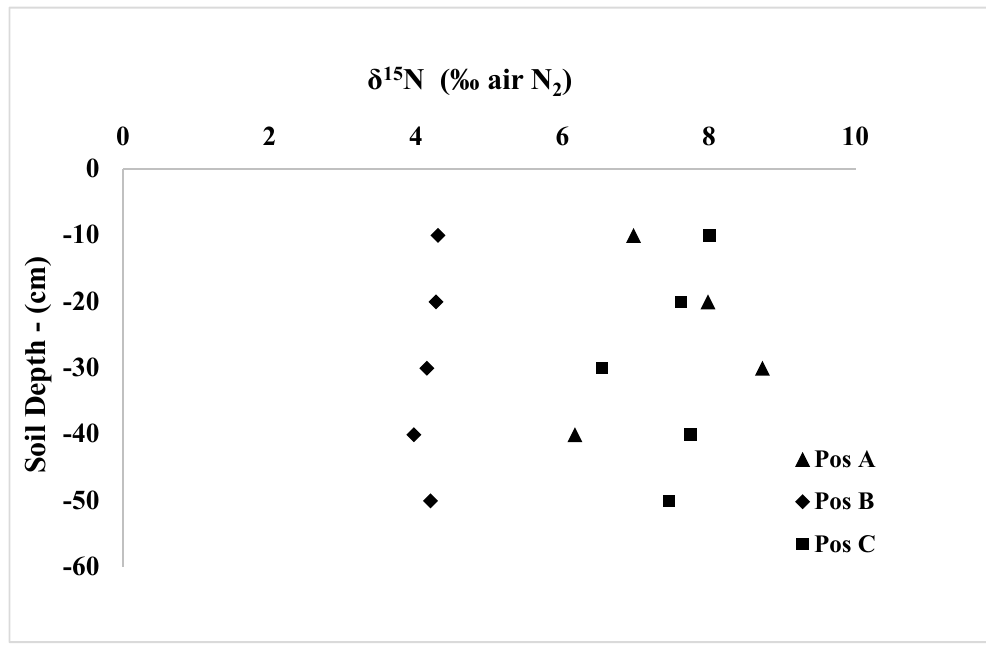
Figure 5. δ 15 N ‰ values of the bulk soil varying with position and soil depth. Position (Pos) B has the lowest N 2 O-N emission values (see Figure 4B).